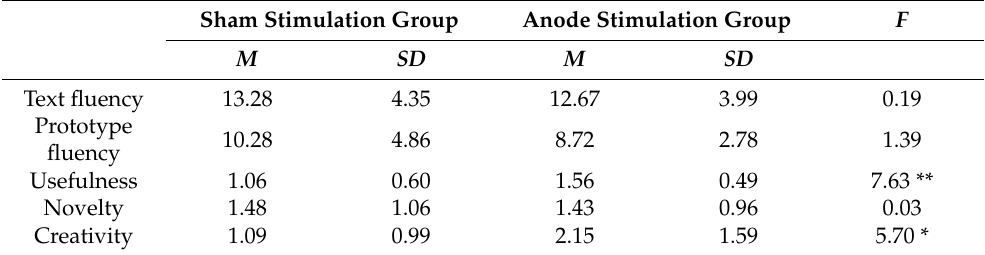
Table 3. The scores of the sham stimulation group and the anodal stimulation group. Sham Stimulation Group Anode Stimulation Group